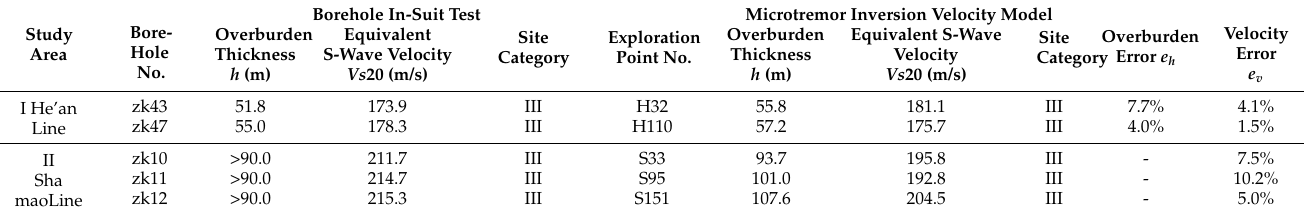
Table 1. Equivalent S-wave velocity, overburden thickness and engineering site category of each borehole and exploration